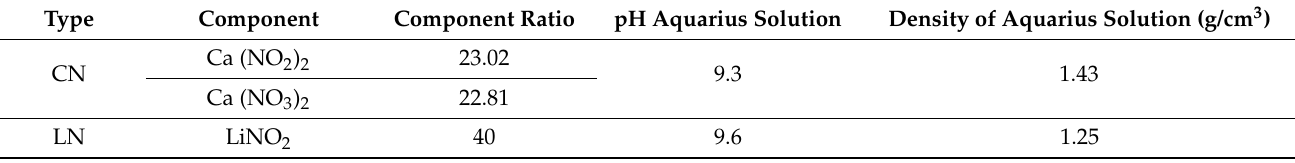
Table 2. Properties of the antifreezing agent.